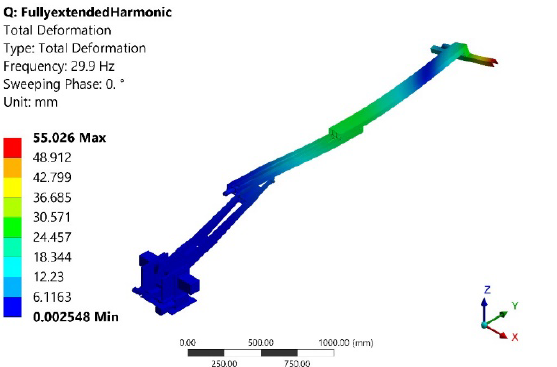
Figure 17. Total deformation (in mm) of the fully-extended configuration structure resulting from the harmonic analysis at the 5th natural frequency (29.9 Hz).